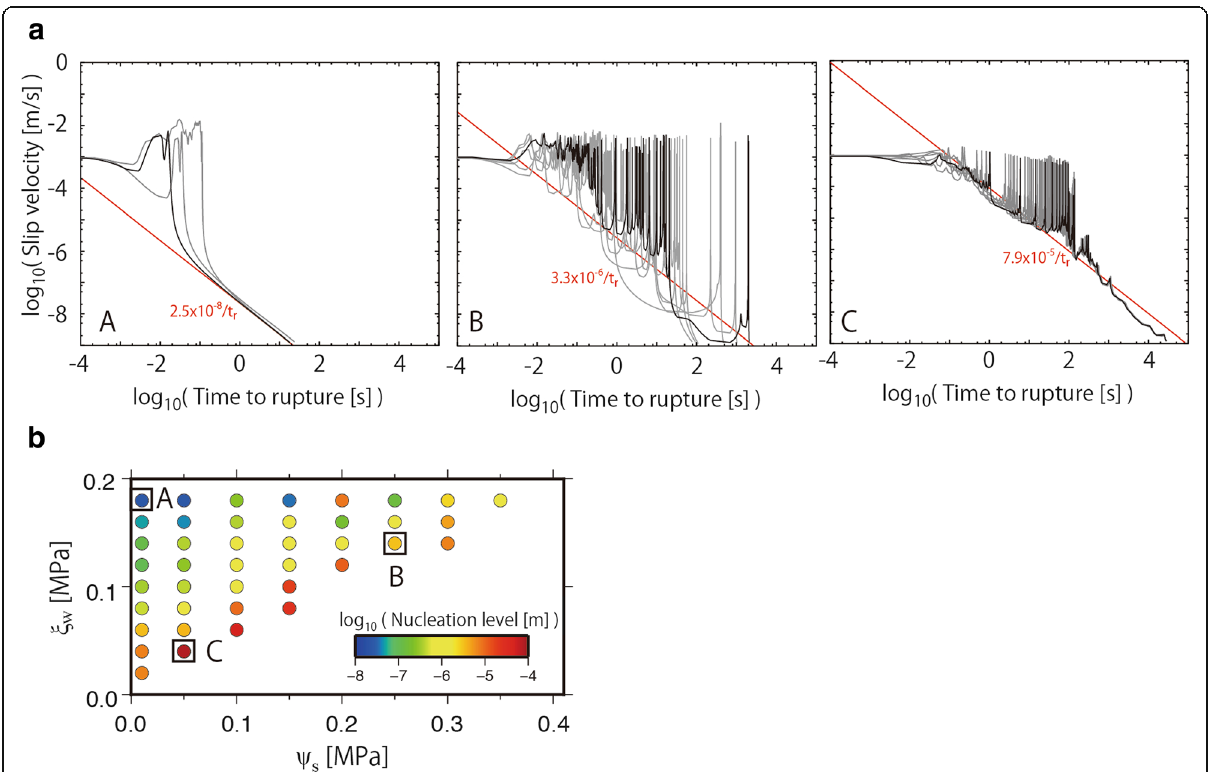
Fig. 6 Estimation of the nucleation level. a Average slip velocity plotted against the time remaining before the mainshock for parameter sets A – C. Black curves represent events indicated by blue arrows in Figs 2 and 3. Grey curves represent other mainshocks shown in Fig. 2. Red lines are fitted power law functions. Red text gives the estimated values of the nucleation level. b Results of parameter studies. The colors indicate the nucleation level D . Parameter sets A – C shown in a are denoted by